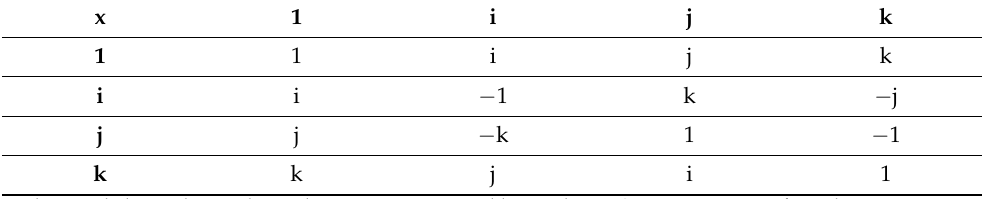
Table 1. Coquaternion q = a1 + bi + cj + dk